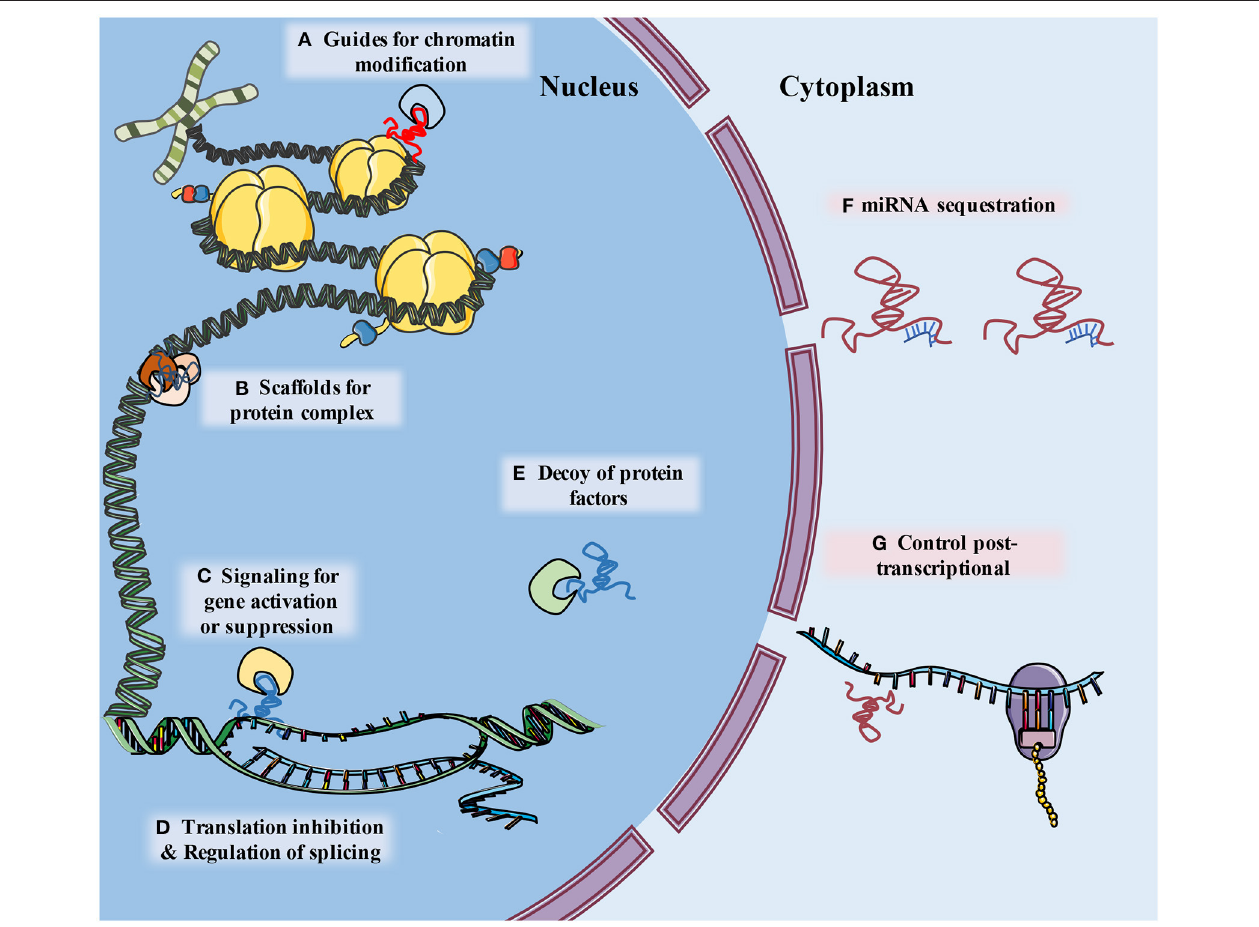
FIGURE 1 | The schematic diagram describes classification of lncRNA functions. (A) LncRNAs guide ribonucleoprotein complexes to specific location of chromatin. (B) LncRNAs support assembly of protein complex. (C) lncRNAs serve as molecular signals for tissue and temporary specific activation of transcription. (D) LncRNAs can alter splicing patterns of mRNA and suppress transcription by sequestering transcription factors. (E) LncRNAs can bind to and take away protein factors, such as transcription factors and chromatin modifiers, to influence transcriptome. (F) LncRNA can “sponge” miRNA by base pairing with their complementary base sequence and reduce their effects (G) lncRNAs may interact with a variety of RNA binding proteins (RBPs), leading to alternations of mRNA stability, splicing, protein stability and subcellular localization.